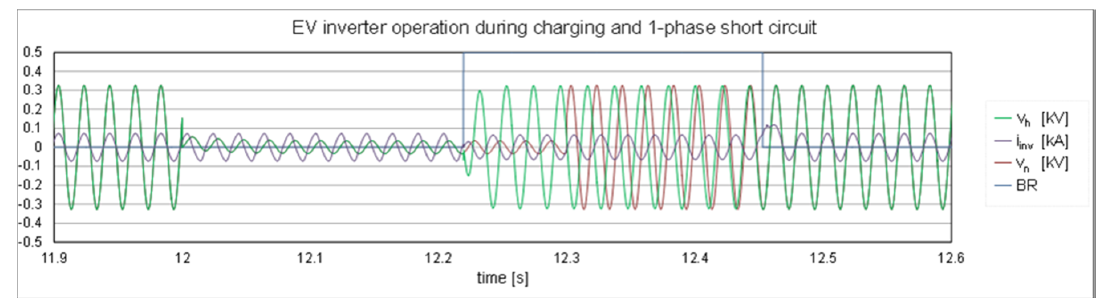
Figure 8. Inverter voltage and current and the network voltage during charging, 1-phase short circuit,